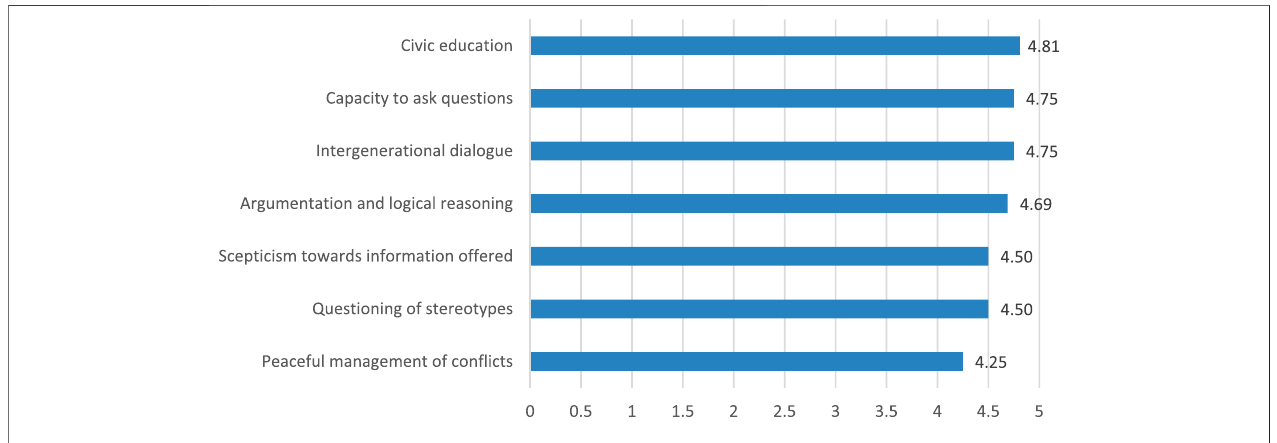
FIGURE 10 | Mean evaluation of the learning fostered by the Way of St.